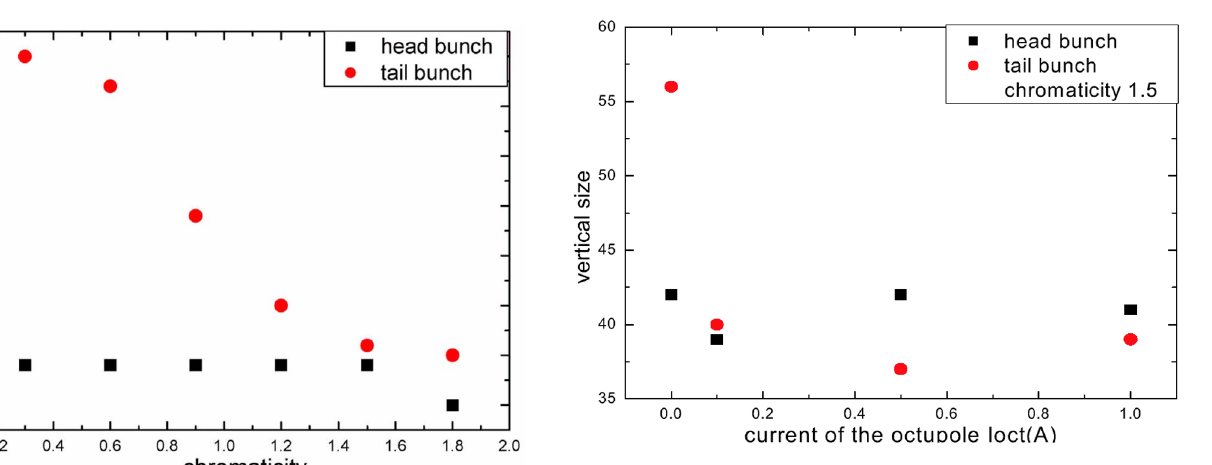
FIG. 29. (Color) Vertical beam size of the first and last bunch in a train as a function of the octupole strength at BEPC in 2004 [38]; the beam size was measured by a streak camera.